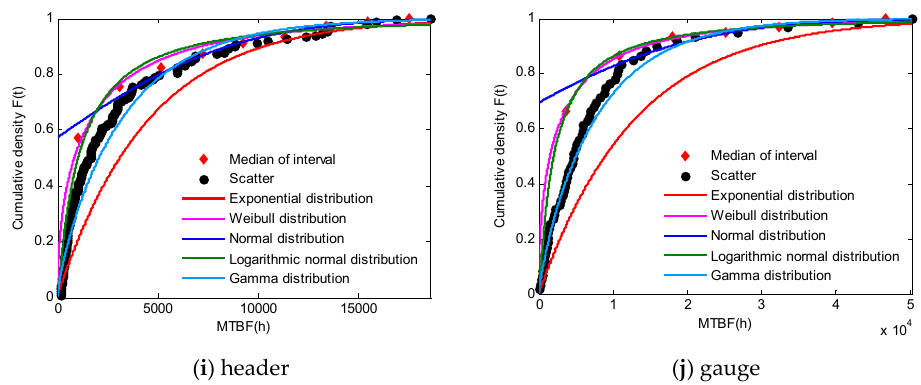
Figure 3. Cumulative distribution curve of each subsystem. CNC—computer numerical control; MTBF—mean time between failures. ( a ) base; ( b ) CNC; ( c ) spindle; ( d ) feeder; ( e ) electrical; ( f ) hydraulic; ( g ) cooler; ( h ) lubrication; ( i ) header; ( j )